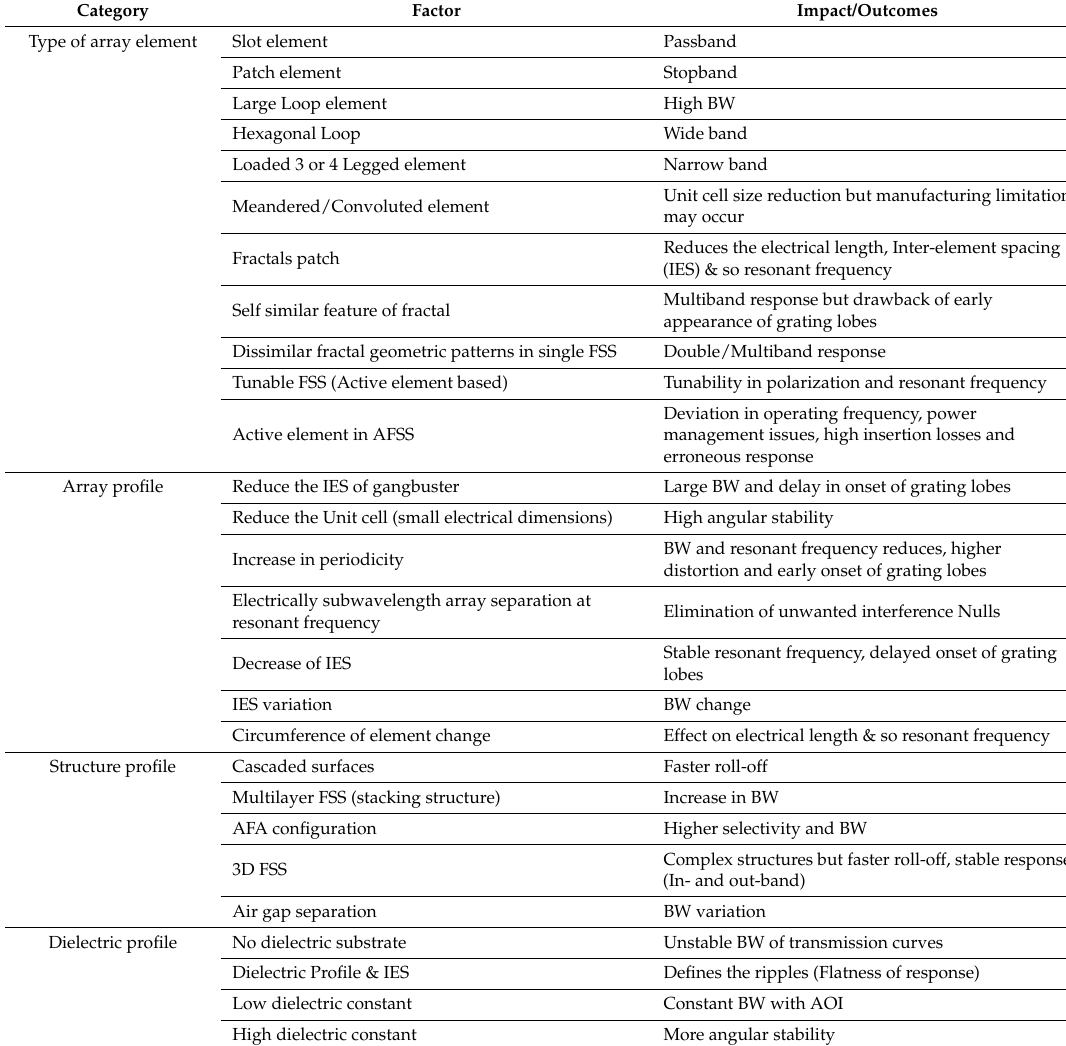
Table 10. Summary of the key factors linking the structure geometries, and performance characteristics.